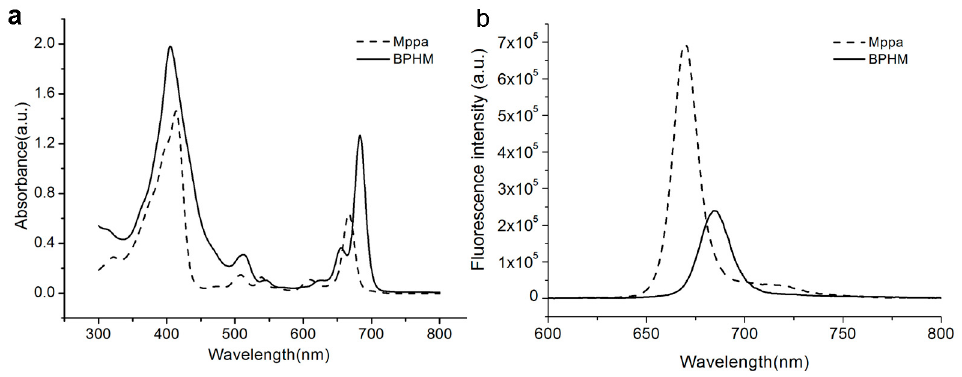
Figure 1. Absorption ( a ) and fluorescence spectra ( b ) of Mppa, BPHM in CH 3 OH (2.15 × 10 − 5 M for UV absorption spectrum, 2.5 × 10 − 7 M for fluorescence spectrum).